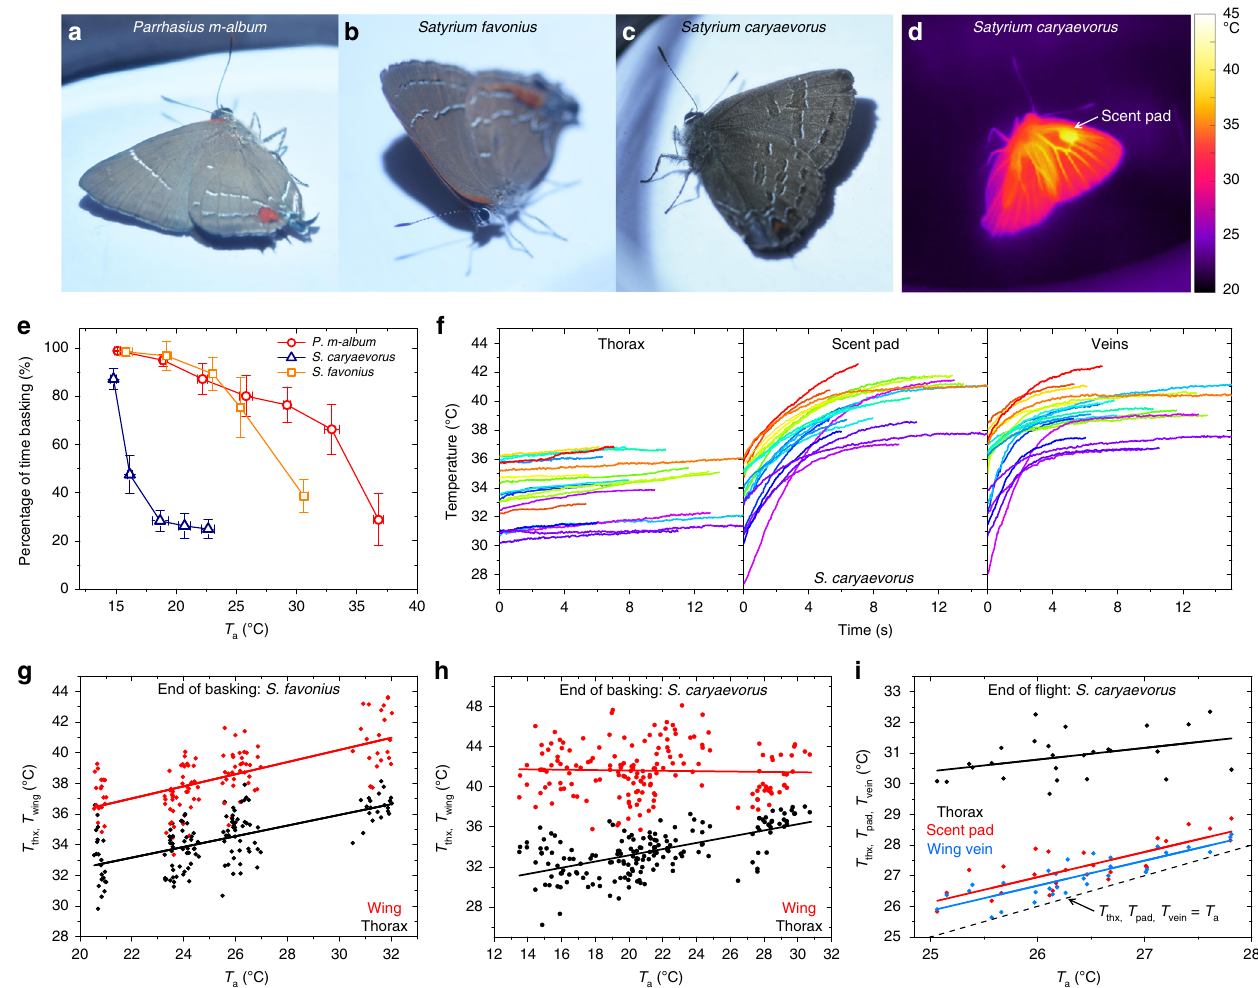
Fig. 7 Basking behavior of three species of hairstreak butter fl ies. a – c Photos showing lateral basking of P. m-album, S. favonius , and S. caryaevorus . d Thermal camera image of an adult of S. caryaevorus (uncorrected for the emissivity distribution on the butter fl y) at the end of a representative basking event, showing that the scent pads and veins are much hotter than the thorax. e Summary of the basking experiments showing that the percentage of time spent basking decreases as the ambient temperature, T a , increases for the three species of hairstreak butter fl ies, and that under the same conditions, the S. caryaevorus butter fl ies ( n = 6) require far less basking than do those of P. m-album ( n = 10) and S. favonius ( n = 4). Supplementary Movies 10, 11 show, respectively, basking of S. caryaevorus and P. m-album at low and high ambient temperatures. Error bars represent one standard deviation of uncertainty. f Recorded temperature increases as a function of time during 20 basking events for an individual of S. caryaevorus . The experimental conditions are T a = 21.5 °C and lamp power of 66.0 mW/cm 2 (corresponding to 2/3 of full sun). g , h Temperatures of the wing and thorax at the cessation of basking for S. favonius ( n = 4) and S. caryaevorus ( n = 6), respectively, with lamp intensity corresponding to 2/3 of full sun and for a variety of ambient temperatures. i Data showing the temperatures of the thorax, scent pad, and wing veins at the point when a S. caryaevorus butter fl y stops fl ying. Source data are provided as a Source Data fi above (Fig. 3). The radiative energy loss from the heated wing to the cold sky , which represents a major channel of heat dissipation in addition to heat losses via were then used in the transfer matrix method to calculate the absorption spectrum convection. of a thin fi lm of chitin. In Eq. (1), m labels the various vibrational and rotational In the thermodynamic experimental setup (Supplementary Fig. 33), the light ω produced by a Xenon lamp shining from above at a distance of about half a meter 0,m is the m th resonance frequency. The values of plasma frequency, p,m , was used to simulate sunlight. The lamp occupied only a small solid angle in and collision frequency, γ m , were simultaneously tuned to obtain the best fi t the top hemisphere. The lab space over the top hemisphere was maintained at T a = between the calculated absorption spectrum and a measured spectrum from a piece 25 °C to simulate the terrestrial environment. A temperature controllable cryostat of butter fl y wing membrane with scales carefully removed, which can be equipped with an infrared-transparent window underneath the wing specimen was considered as a relatively fl at slab with a uniform thickness. The absorption used to simulate the sky in different weather conditions. spectrum of the scale-less wing membrane was measured using a Fourier transform The cryostat consists of a vacuum cryostat chamber, a cooled plate located at infrared spectrometer and its thickness was determined using a scanning electron the center of the chamber, and a potassium bromide (KBr) window. The cooled microscope. The obtained complex refractive indices of chitin were used in full- plate is in contact with a liquid-nitrogen-cooled cold fi nger and its temperature can wave simulations to investigate the interactions between infrared light and micro- be controlled within 0.01 °C of a set temperature by using a Lake Shore cryogenic structures of wing scales (Fig. 4h, i). temperature controller. The top surface of the cooled plate that faces the window is coated with a thick layer of paint and has a near-unity mid-infrared emissivity. The KBr window, 1.5 inches in diameter, has a transmissivity >90% over a broad mid- Experimental setup simulating natural radiative environment . A butter fl y wing infrared spectral range ( λ = 2.5 – 20 μ m). The negligible re fl ectivity of the window absorbs sunlight and exchanges energy via thermal radiation with the ambient minimizes re fl ections within the window and between the window and the wing environment, including the terrestrial environment beneath the wing and the sky